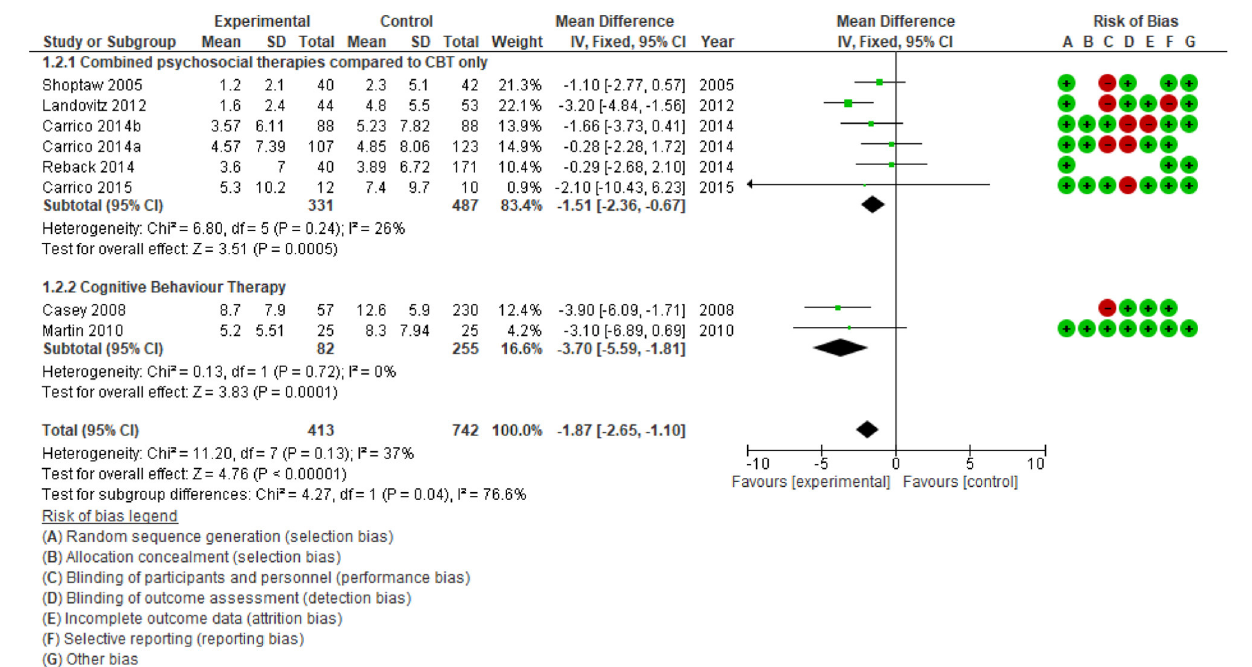
FIGURE 4 | Comparison number of days using drugs after treatment, last 30